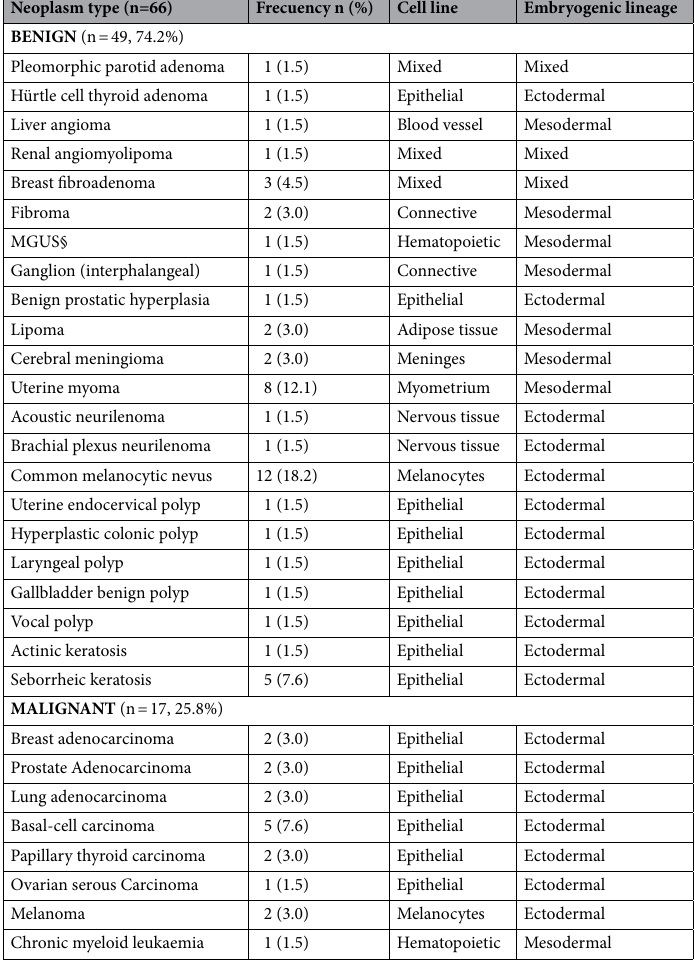
Table 2. Neoplasm types and frequency. § MGUS: Monoclonal gammopathy of uncertain